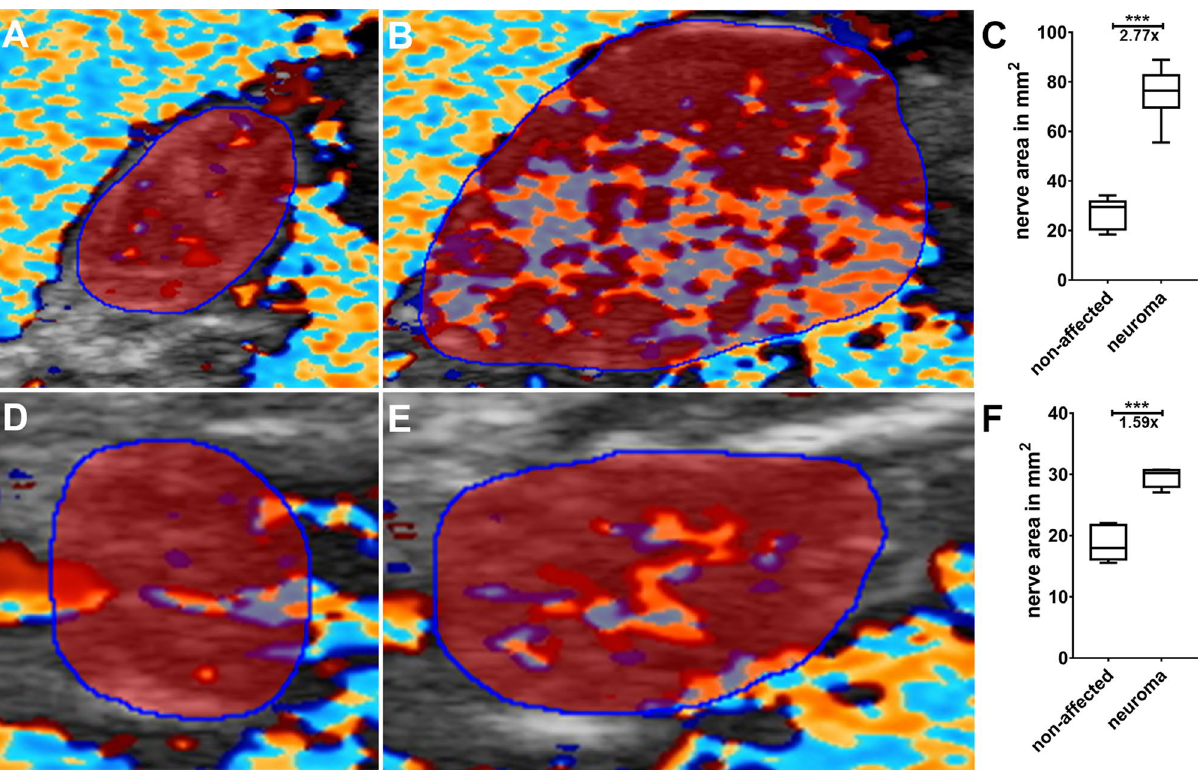
Figure 1. Exemplary quantification of the cross-section area (labeled in red) of the intact nerve portion ( A , D ) and neuroma ( B , E ). The cross-section area is significantly increased compared to the intact nerve portion ( C , F ). The CSR was calculated based on six images for the affected and unaffected nerve